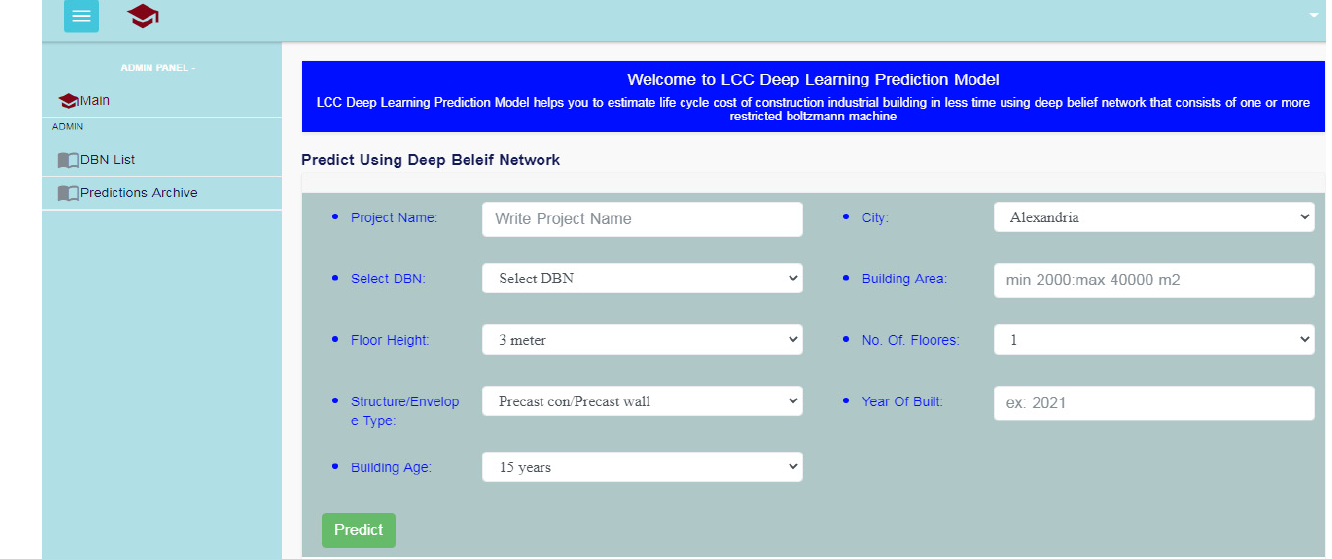
Figure 6. How the program works. 4. Validation and Implementation with Case Study 4.1. Validation of the Network The validity of the utilized LCC prediction model is considered a crucial concept. Therefore, seven case studies of precast industrial buildings are devoted in this section to validating the prediction modelling procedures. The inputs and the actual LCCs of the seven case studies were obtained from the Modern4concrete group in Egypt, and are dis- played in Tables 4 and 5 for the year of 2021.The values are forecasted for 30 years of building age from the year of 1991, extracted from deep learning input simulations, as